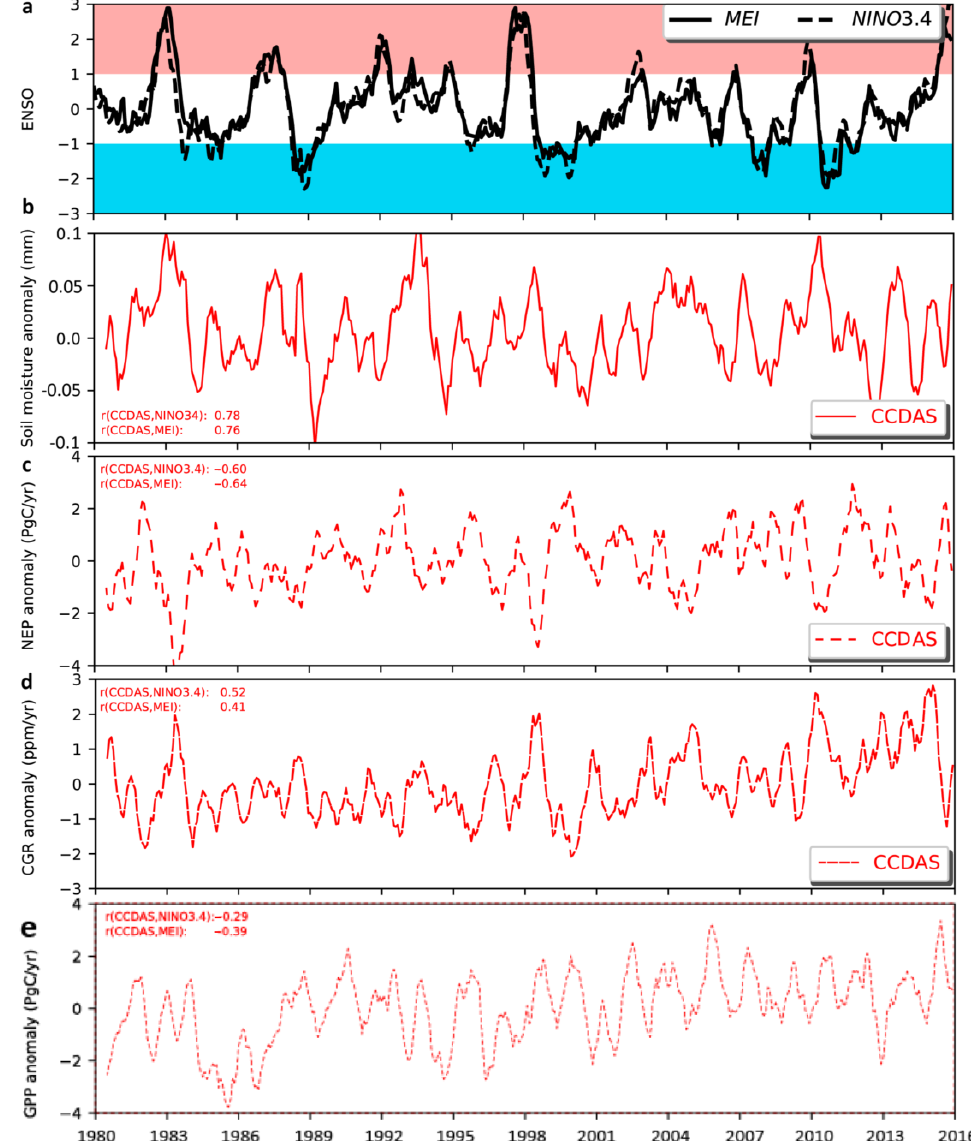
Figure A3. Inter-annual variability of ENSO indices, soil water, NEP, and CO 2 concentrations. ( a ), normalized anomalies for two ENSO indices, MEI (Multivariate ENSO Index) and Niño 3.4, anomalies are calculated by removing mean seasonality during 1980 – 2015, then normalized by standard deviations for the same period. ( b ), soil moisture anomalies calculated from zonal mean soil moisture (30° N-60° N) by removing mean seasonality during 1980 – 2015 and then smoothed with a 7-month moving average method, for both the CCI remote sensing data and CCDAS-optimized soil moisture. ( c ), NEP anomalies calculated from global mean CCDAS-optimized NEP using the same method as soil moisture. ( d ), global CO 2 growth rate (CGR) anomalies calculated from the global CO 2 concentrations by mixing CO 2 concentrations from Mauna Loa (MLO) and South Pole (SPO), 0.75 × MLO + 0.25 × SPO, and deriving the growth rate by removing mean seasonality, then a 7-month moving average is used for SIO CO 2 concentrations and CCDAS-optimized CO 2 concentrations, respectively. ( e ), GPP anomalies calculated from global mean CCDAS-optimized GPP using the same method as soil moisture. Correlation coefficients (Pearson r ) are derived from the best values at different time lags between different variables and strong El Niño/La Niña events (values from the colored region in Figure 1a).